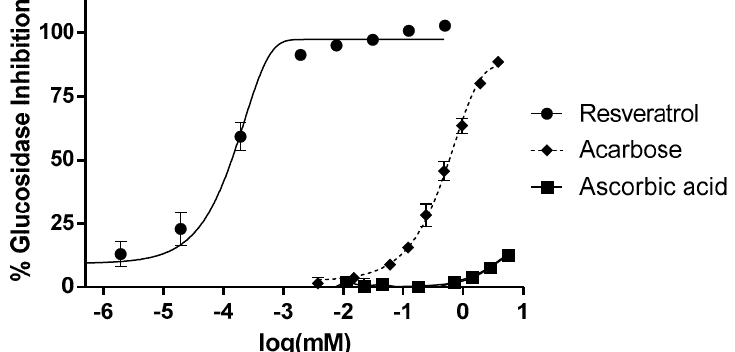
Figure 1. α -Glucosidase activity is dose-dependently inhibited by resveratrol. The x axis represents the logarithm of compound concentration in mM. Tested concentrations of resveratrol were in the range of 2 × 10 − 7 –0.5 mM. IC 50 were calculated by non-linear regression, using GraphPad Prism 6. Acarbose was tested as a positive control drug in the range of 0.004–3.9 mM. Ascorbic acid (vitamin C) was tested as an antioxidant reference in the range of 0.005–5.7 mM. All concentrations were tested at least in triplicate, each point representing mean ± SEM.